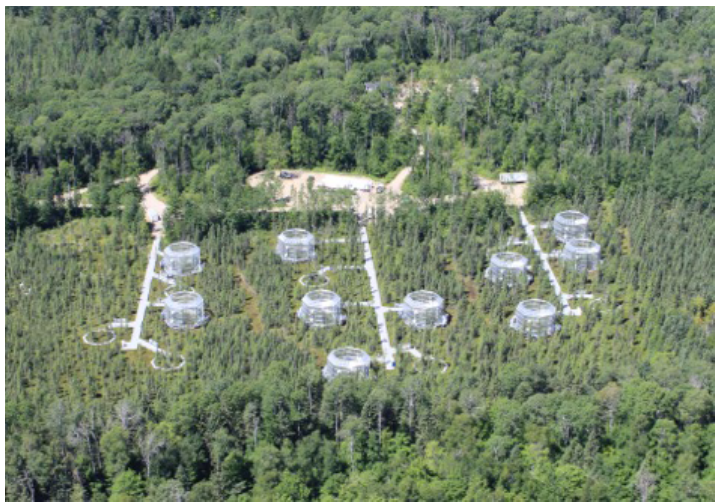
Figure 1. Aerial view of the SPRUCE experimental